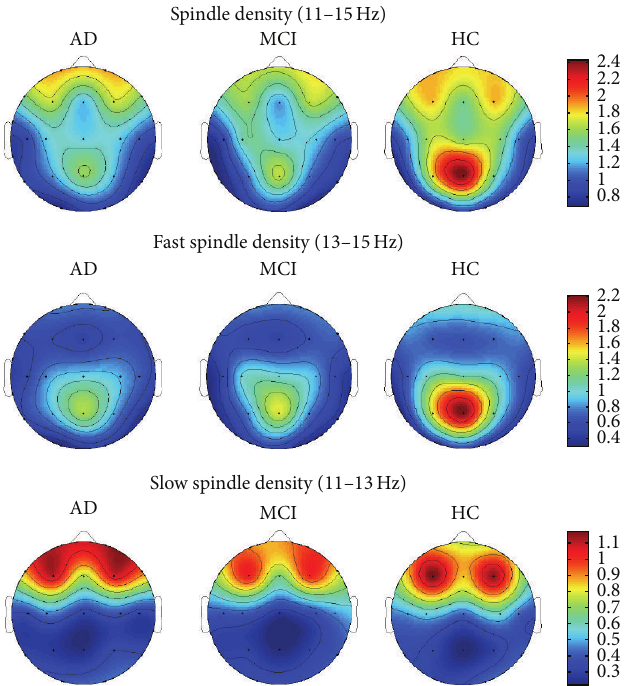
Figure 1: Whole range (11–15Hz), fast (13–15Hz), and slow (11–13Hz) spindle density topographical scalp maps in AD patients, amnesic MCI patients, and HC. The maps are based on the 19 derivations of the 10–20 system (electrodes positions indicated by black dots). Values are color-coded and plotted at the corresponding position on the planar projection of the hemispheric scalp model. Values between electrodes were interpolated (biharmonic spline interpolation). Values are expressed in terms of number of spindles divided by artifact-free NREM sleep